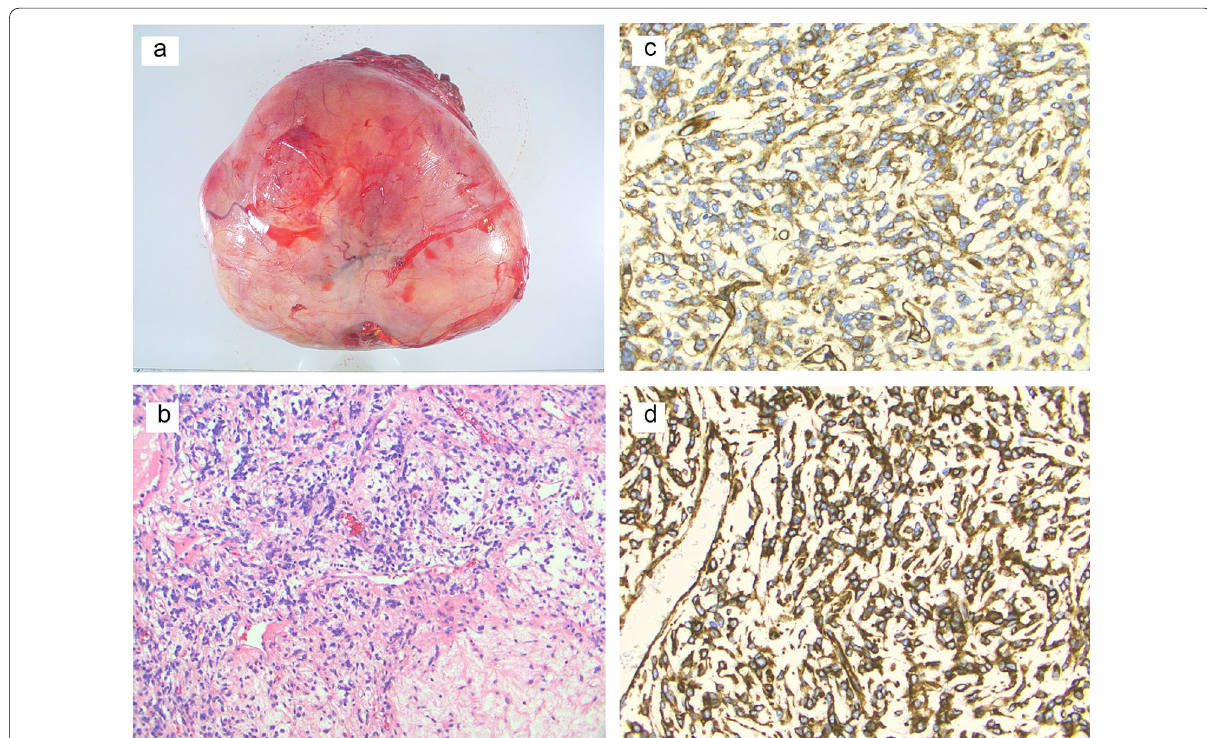
Fig. 2 Surgical specimen and histological findings (HE and immunohistochemical staining). a Macroscopic findings showed a well-circumscribed and encapsulated elastic hard tumor, 16 16 10 cm; b tumor consisted of spindle-shaped cells with a patternless arrangement and × × hemangiopericytomatous appearance (